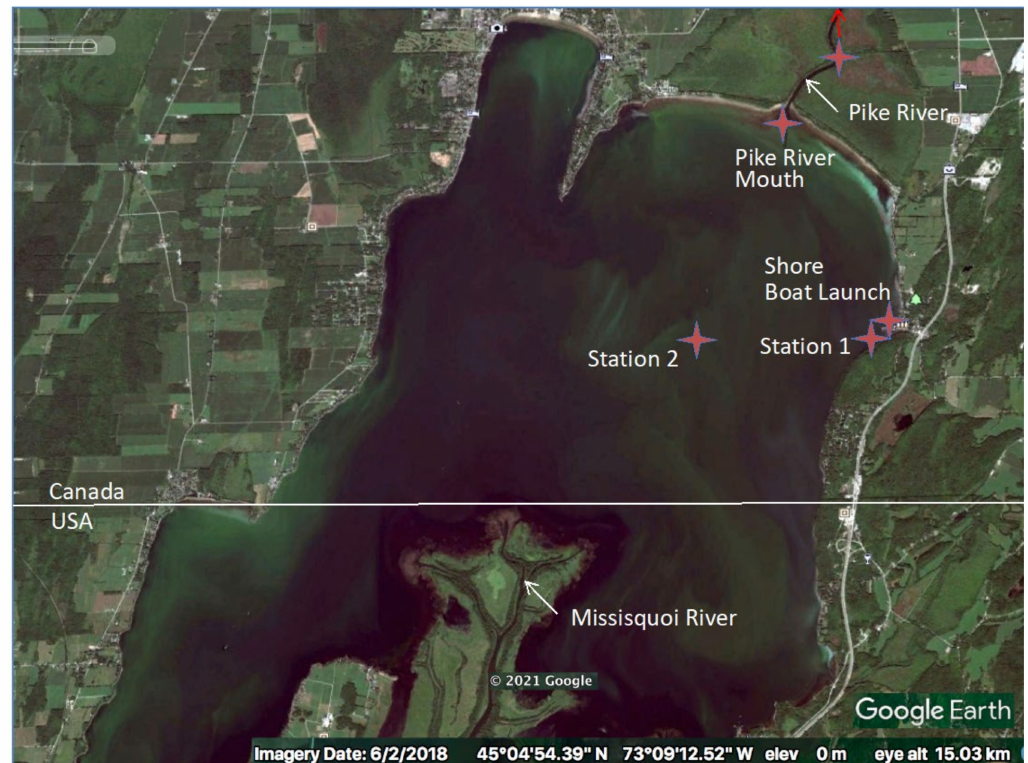
Figure 2. Sampling locations in Missisquoi Bay, Lake Champlain, in 2017 and 2018. Google Earth, 2 June 2018 [35]. Stations include the tributary Pike River (PR); Pike River mouth (PRM); Littoral Station 1 (St1); Pelagic Station 2 (St2) and Shore Boat launch